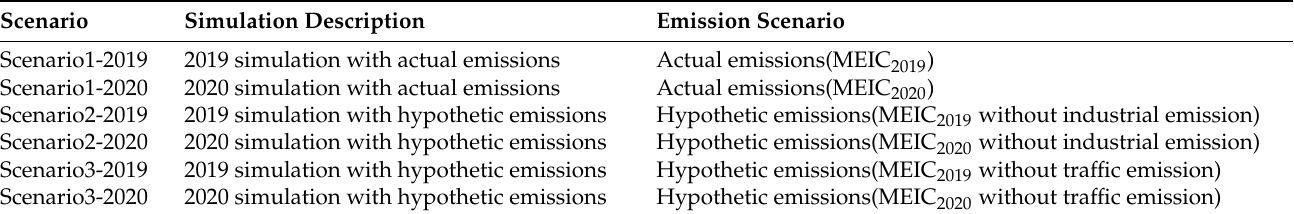
Table 2. Emission scenario